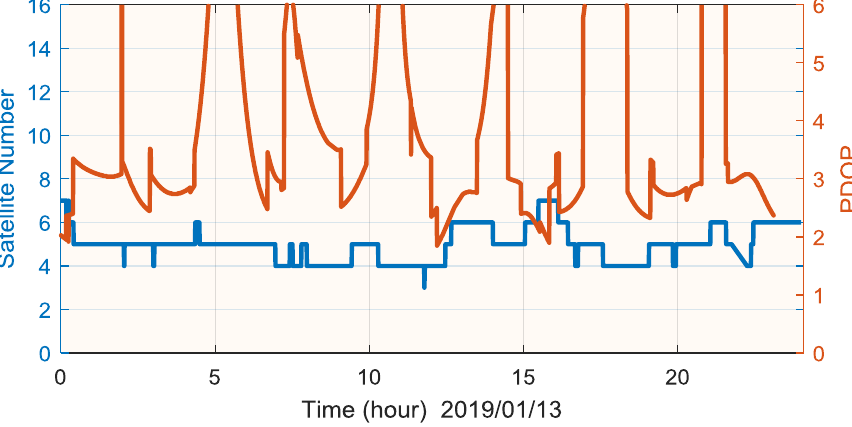
Figure 11. Satellite number and PDOP of BDS-3 at station BSHM.